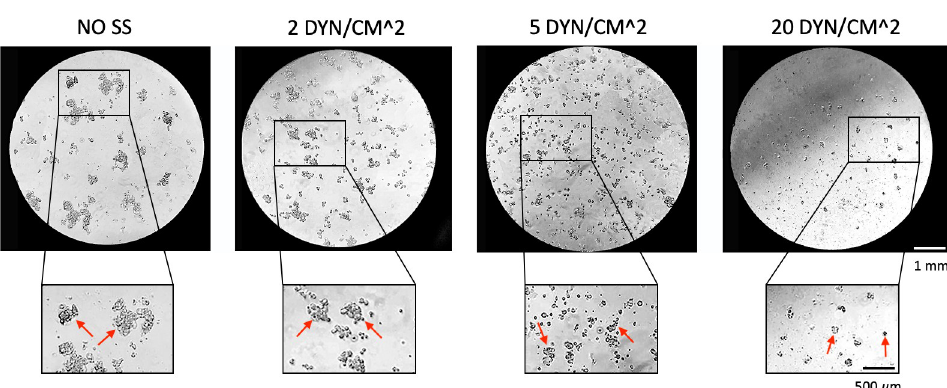
Fig 6. Clusters size reduction at different shear stress levels. Clusters size reduction after 6 hours of circulation at different shear stress.